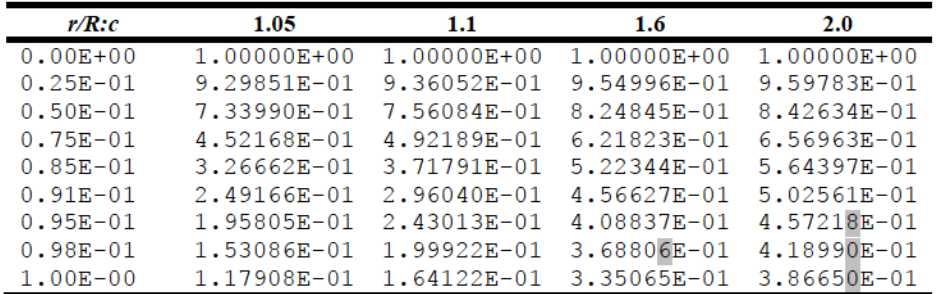
Figure 2. Table 3.4.4 from [5] Critical flux